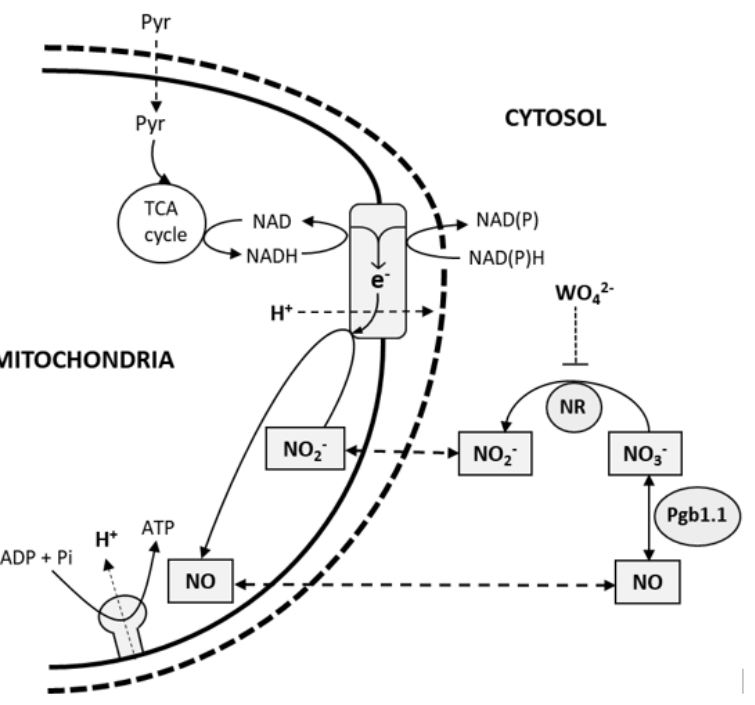
Figure 1. Schematic representation of phytoglobin (Pgb)-NO respiration in hypoxic roots and nodules. Inside mitochondria, pyruvate is oxidized through the tricarboxylic acid (TCA) cycle to generate NADH. Mitochondrial internal dehydrogenase and external dehydrogenases, respectively, oxidize matricial and cytosolic NADH and NADPH. Electrons are transferred to either alternative oxidase or cytochrome oxidase. Nitrite (NO 2 − ) is reduced into NO at both alternative oxidase and cytochrome oxidase sites. NO diffuses into the cytosol, where it is oxidized into nitrate (NO 3 − ) by phytoglobins (Pgb1.1). Nitrate reductase (NR) reduces NO 3 − into NO 2 − , which is transported into the mitochondria. ATP is synthesized due to the trans-membrane electrochemical gradient generated by proton (H + ) pumping at the different sites of the electron transfer chain. Tungstate (WO 4= ) inhibits Pgb–NO respiration via NR inhibition. Pyr, pyruvate.